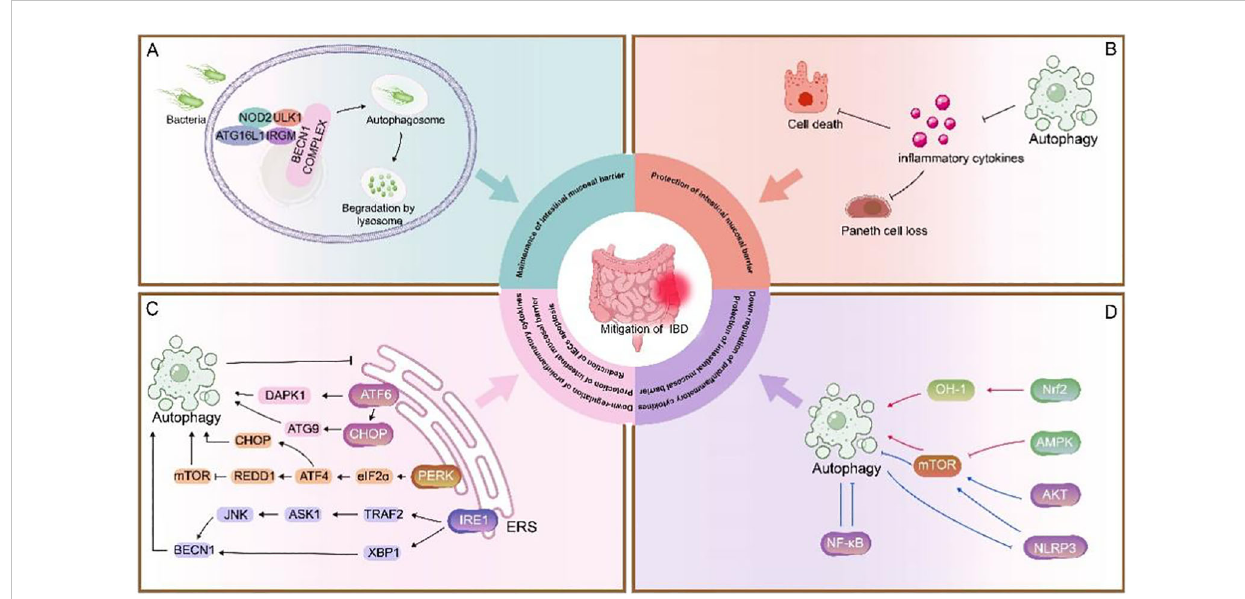
FIGURE 2 Role of autophagy in IBD. (A) NOD2 recruits ATG16L1 to the plasma membrane at the bacterial entry site, initiating autophagy. Association of IRGM with NOD2 promotes IRGM ubiquitination and the assembly of the core autophagy machinery, promoting xenophagy and intracellular bacterial clearance (135). This process is important for maintenance of intestinal mucosal barrier (48, 121). (B) Autophagy inhibits the secretion of in fl ammatory cytokines to prevent loss of Paneth cells and exaggerated cell death. (C) The UPR is activated in response to ERS and consists of three pathways: ATF6, PERK, and IRE1. These three stress-related proteins bind to GRP78 when the cell is in a steady state. Under ERS, GRP78 separates from these three receptors and activates the ATF6, PERK, and IRE1 pathways. 1) ATF6 is cleaved in the Golgi apparatus, binds to speci fi c DNA, regulates the pro-apoptotic cytokine CHOP, mediates mAtg9 transport, and activates autophagy; it also activates autophagy by upregulating DAPK1 (88, 89). 2) PERK activates eIF2 a through autophosphorylation, thereby activating ATF4, which induces the expression of CHOP and the upregulation of autophagy genes. ATF4 also induces the expression of REDD1 and inhibits mTOR phosphorylation to activate autophagy (87, 91 – 93). 3) IRE1 splices XBP1 into its active form and can bind to TRAF2 to activate JNK, thereby upregulating Beclin-1 and promoting autophagy. Autophagy and ERS are mutually regulated (96, 97). ERS can promote autophagy, and when ERS is overactive, activated autophagy can inhibit ERS, thereby reduction of IECs apoptosis, down-regulation of proin fl ammatory cytokines, protection of intestinal mucosal barrier. (D) In this section, the red line represents the Pro-autophagy pathway pathway and the blue line represents the inhibition of autophagy pathway. Autophagy is primarily regulated by the following pathways:1) mTOR is a key negative regulator of autophagy. The AMPK/mTOR pathway positively regulates autophagy (125); The NLRP3/mTOR and AKT/mTOR pathways negatively regulate autophagy (133, 137), whereas the upregulation of autophagy also inhibits NLRP3 in fl ammatory vesicle activation (132). 2) Nrf2-OH pathway positively regulates autophagy (150).3) The NF- k B pathway negatively regulates autophagy and vice versa (142, 144, 145). Autophagy-related signaling pathways bene fi t protection of intestinal mucosal barrier and down-regulation of proin fl ammatory cytokines,